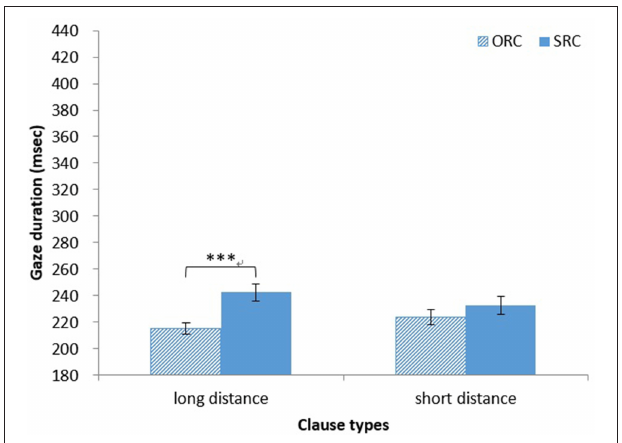
FIGURE 3 | Chinese group: regression-path duration for HNs in RCs. * p < 0.05 , ** p < 0.01 , and *** p < 0.001 .